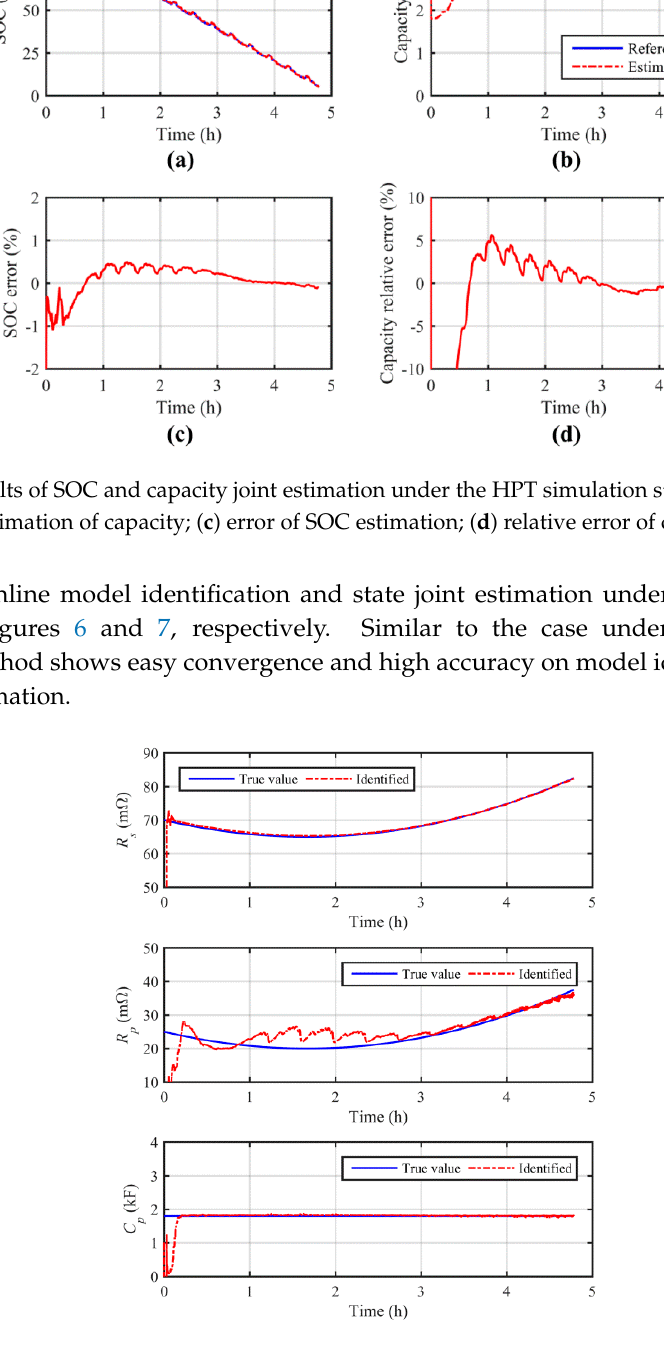
Figure 6. Results of online model parameters identification under the FUDS simulation study.